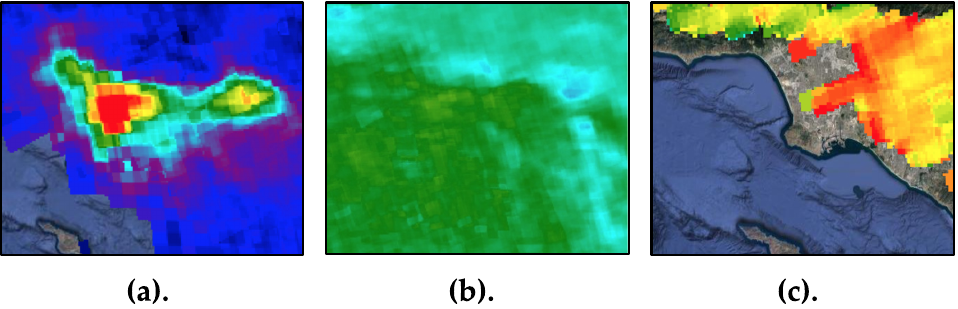
Figure 6. Downsampled TROPOMI remote-sensing data of various air pollutants (1 January 2019 within Los Angeles), ( a ) nitrogen dioxide, ( b ) carbon monoxide, ( c ) methane.